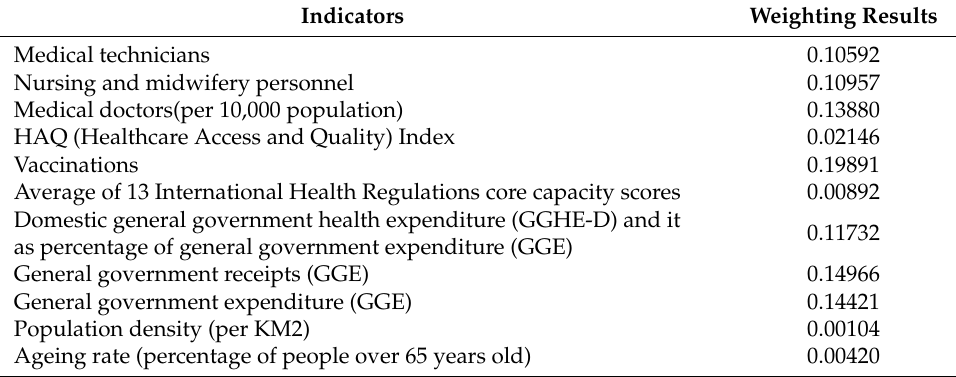
Table 3. Weight distribution of HRCC indicators in 150